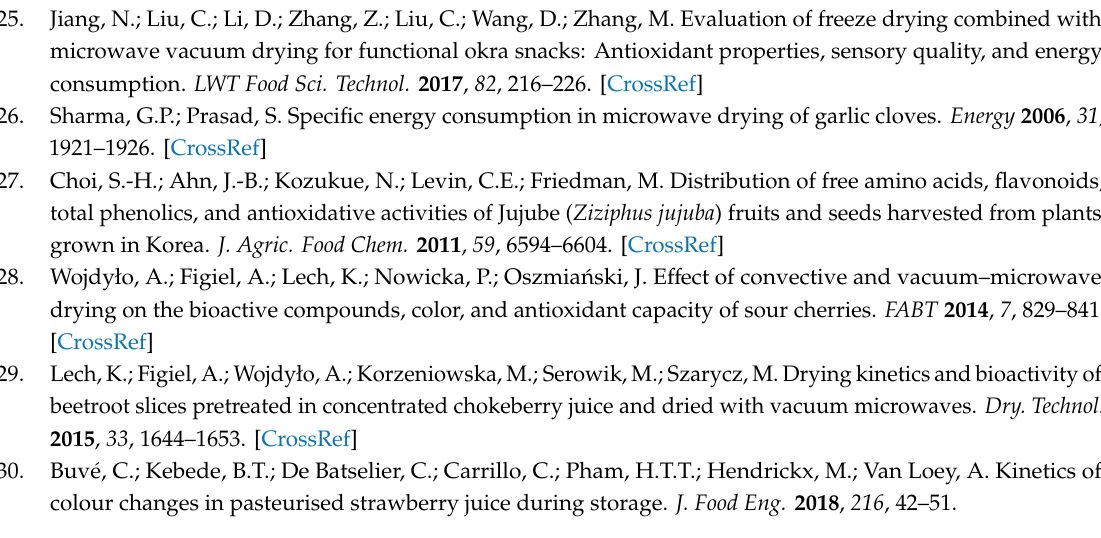
Sample Availability: Samples of the compounds of dried jujube fruits are available from the